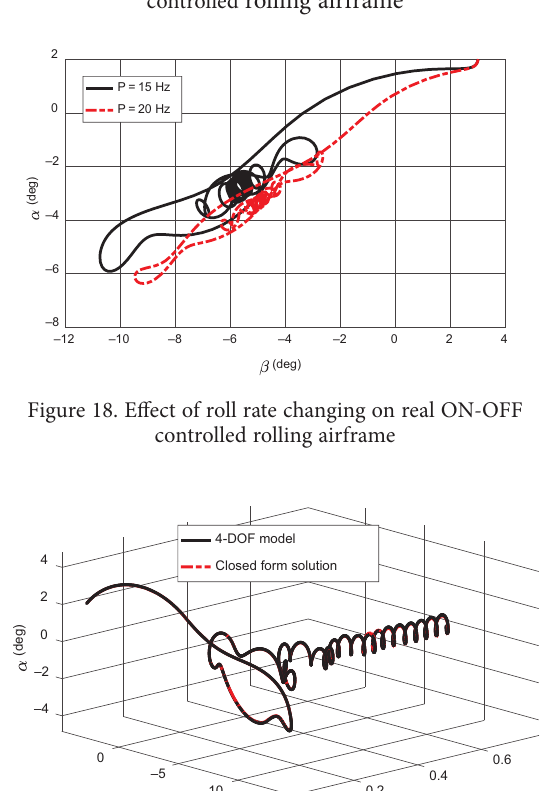
Figure 17. Effect of roll rate changing on ideal ON-OFF